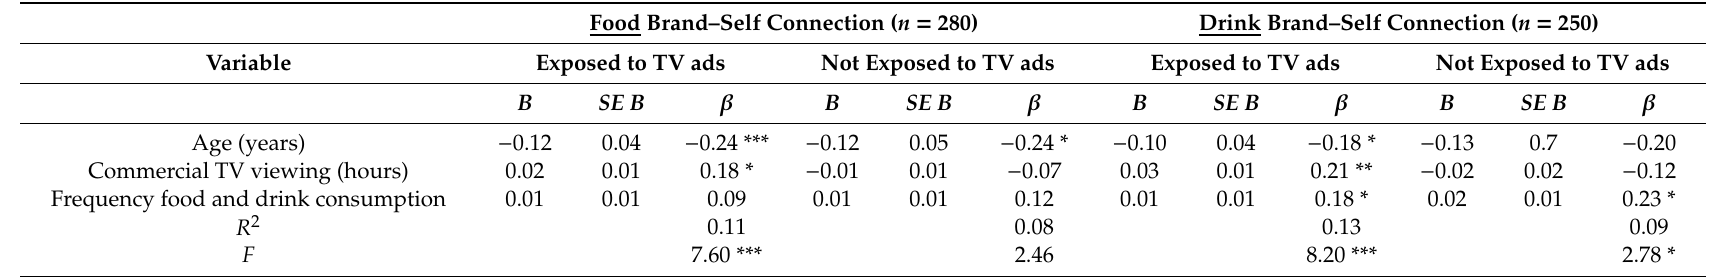
Table 4. Summary of linear regression analyses for variables predicting food and drink brand–self